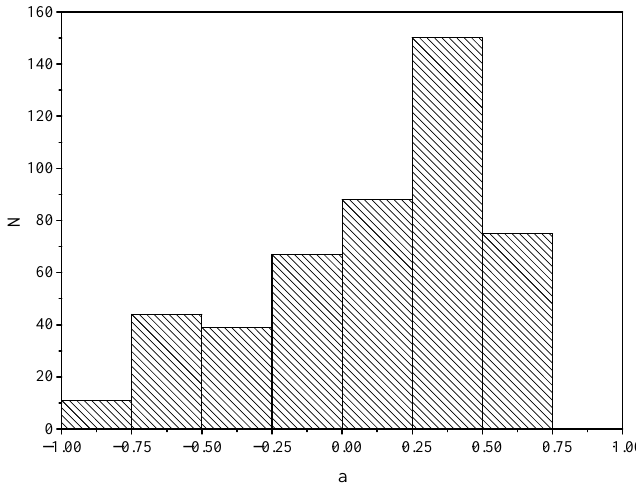
Figure 8. The distribution of the estimated spin values a